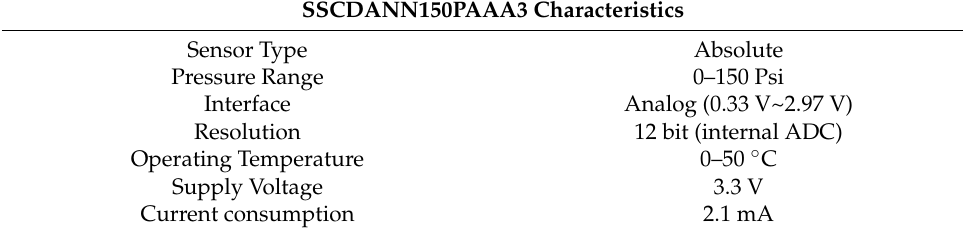
Table 1. Pressure sensor